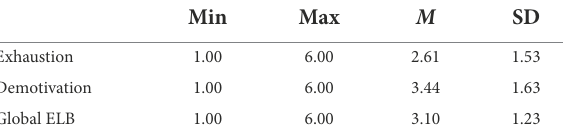
TABLE 5 Global and dimensional levels of students’ ELB ( N =